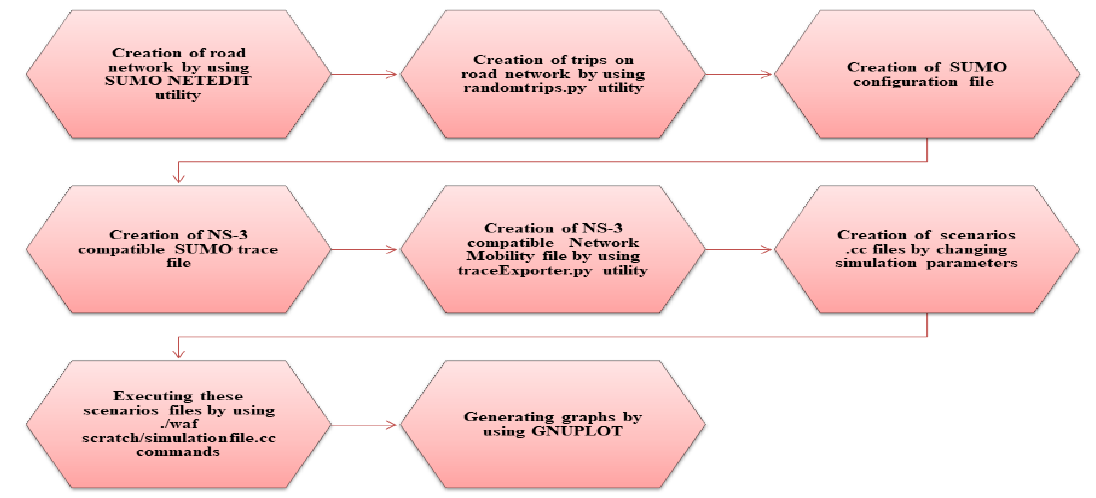
Figure 3. Simulation methodology used in a simulated experiment.